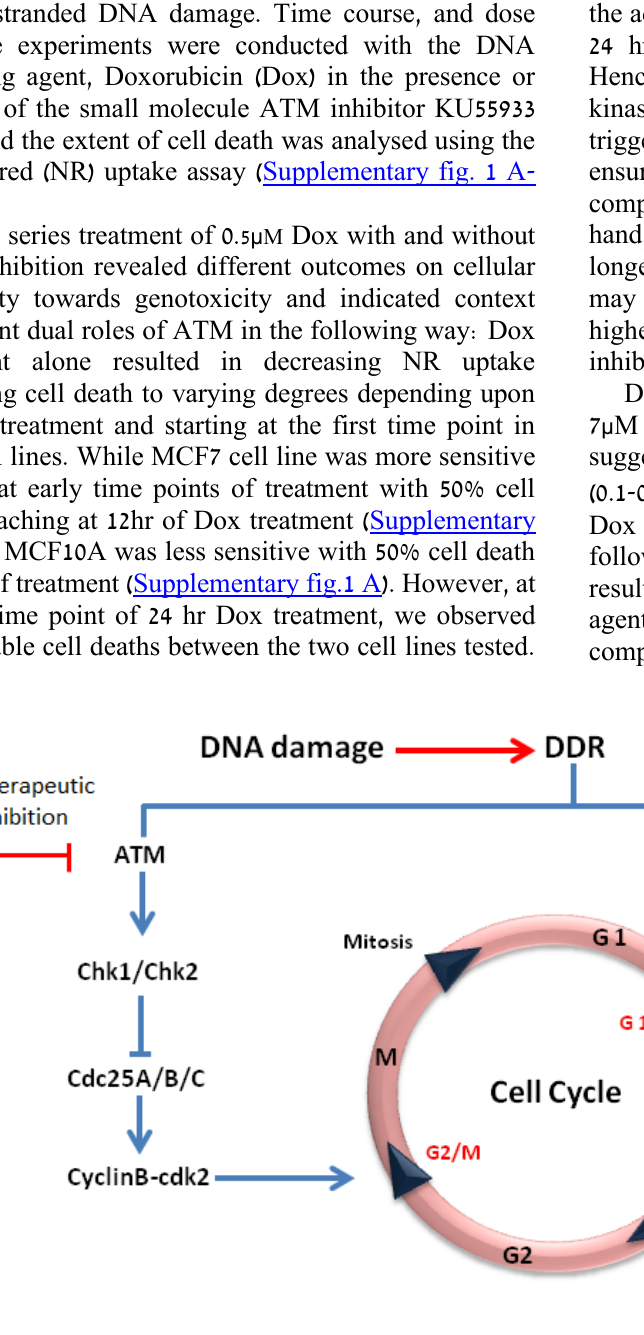
Figure 4: The principle of targeting ATM pathway for achieving targeted cellular sensitivity in cancer therapy. Lines with arrow heads indicate activation, while lines with bar heads indicate inhibition. Red arrow indicates DNA damage caused by radio or chemotherapy while red line with bar head indicates therapeutic inhibition of ATM. Cancer cells with P53 loss of function mutation have a dysfunctional G1/S checkpoint whereas the G2/M checkpoint may still be functional. When cells are exposed to genotoxic agents, DDR pathway is activated which will cause G1/S arrest via P53 pathway and G2/M arrest via checkpoint kinases Chk1 and Chk2 pathway. Normal cells can be arrest in either of these pathways allowing themselves time for DNA repair. However, cancer cells can only be arrested in G2/M pathway via ATM  Chk1/Chk2 pathway. Disruption of G2/M checkpoint by way of ATM inhibition would result in failure of cancer cell to arrest in any checkpoint causing more sensitivity to genotoxic agents while normal cells with functional P53 would still be arrested and